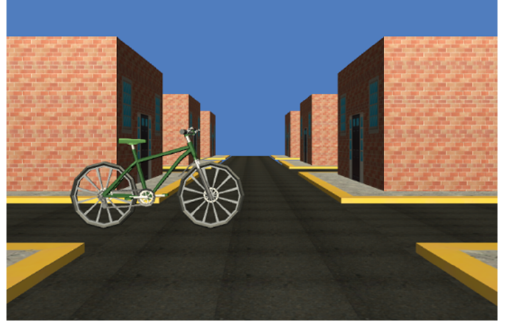
Figure 2. Bicycle in the VE programmed for Simple Reaction Time (SRT) test.